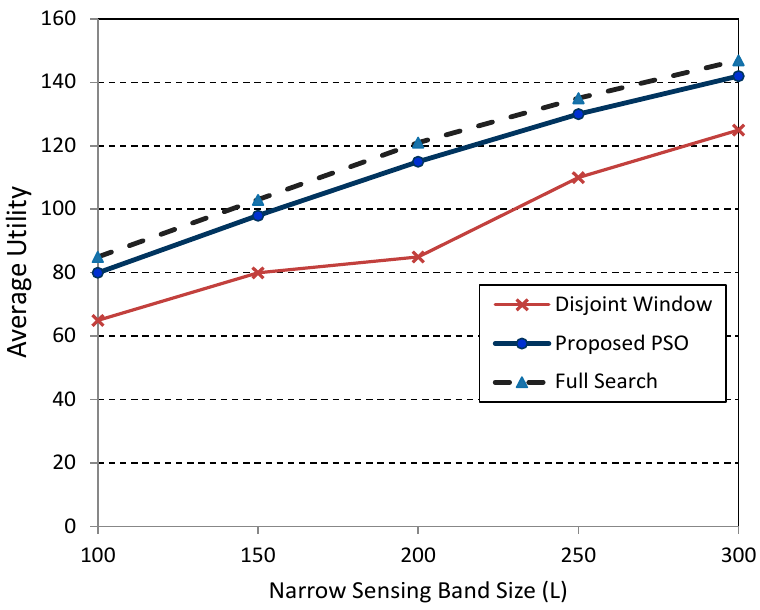
Figure 8. Average utility for narrow sensing band decision.